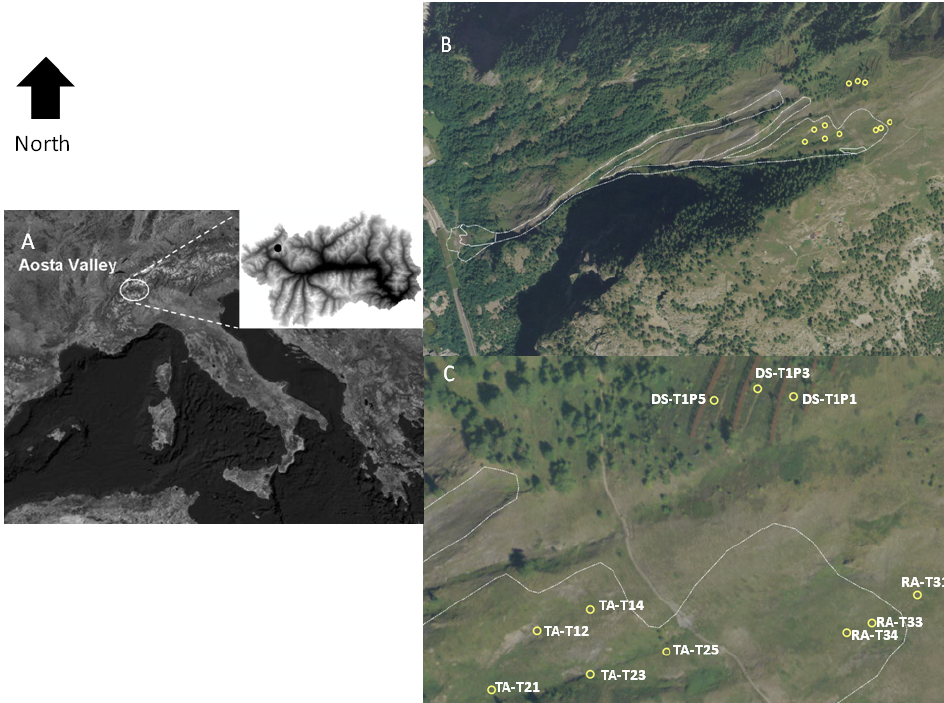
Figure 1. Study area: (A) site location within Italy and the Valle d’Aosta region; (B) avalanche area and sampling points and (C) sampling points in detail. DS: defense structures area; TA: track area; RA: release